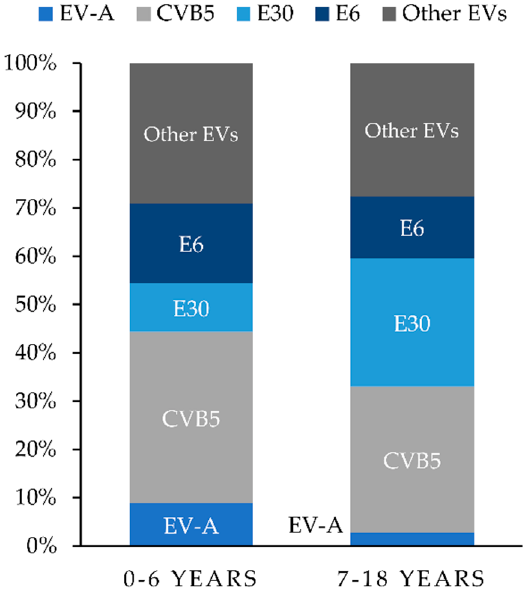
Figure 3. Age distribution by enterovirus types isolated from children with infection of the CNS attributed to enteroviruses in Bialystok, Poland from 2015 to 2019. Abbreviations: EVs, enteroviruses; EV-A, enterovirus A species; CVB5, coxsackievirus B5; E30, echovirus 30; E6, echovirus 6.